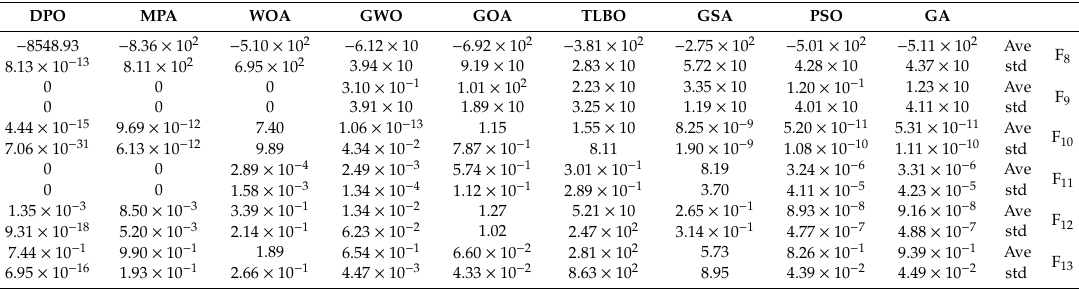
Table 2. Optimization results on multimodal test functions.